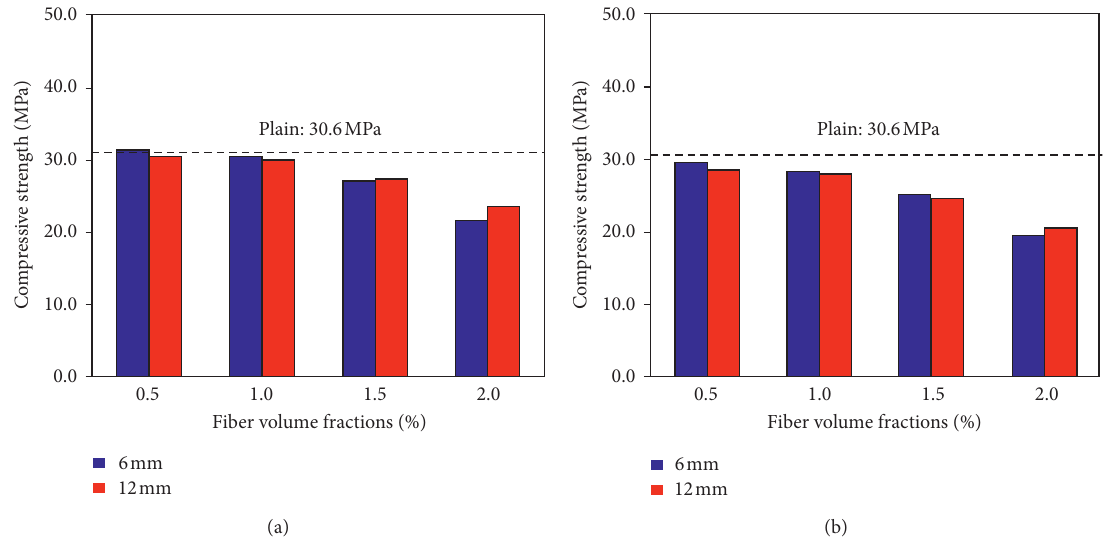
Figure 9: Relationships between compressive strengths of the CFRM composite specimens with different fiber lengths and fiber volume fractions: (a) SiO 2 -coated carbon fiber and (b) uncoated carbon fiber.